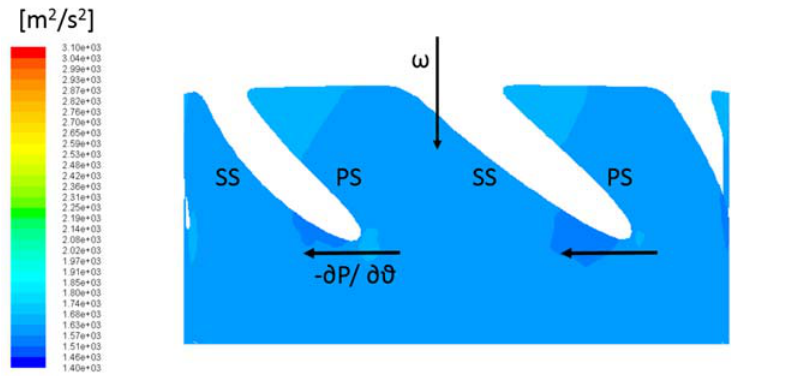
Figure 5. Contours of the static pressure (m 2 /s 2 ) evidencing the pressure gradient across the blade trailing edge at the mean radius.